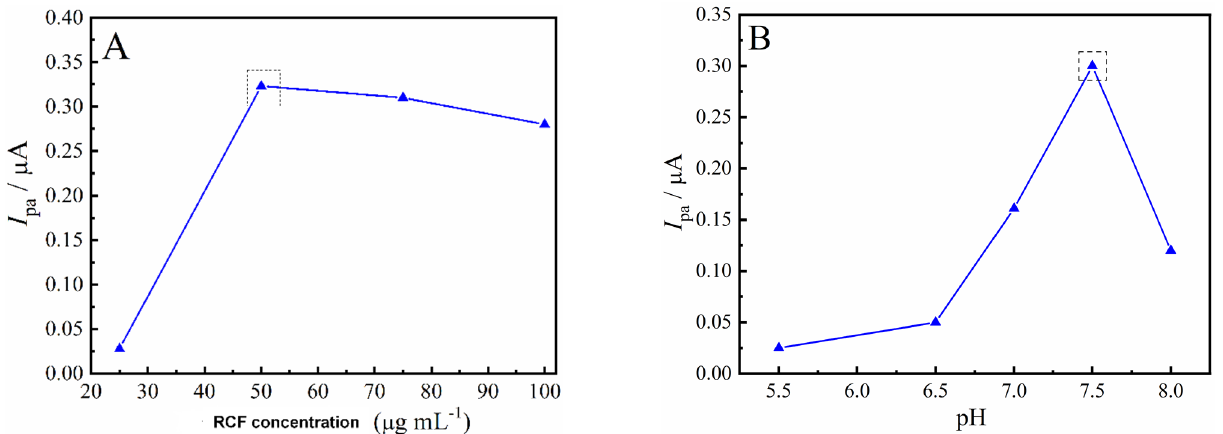
Figure 7. ( A ) Effect of RCF (µg mL − 1 ) concentration and ( B ) effect of pH on the anodic peak current of thiocholine oxidation for the GC/RCF/AChE biosensor in a 0.2 mol L − 1 PBS solution containing 50.0 µmol L − 1 of AChI.